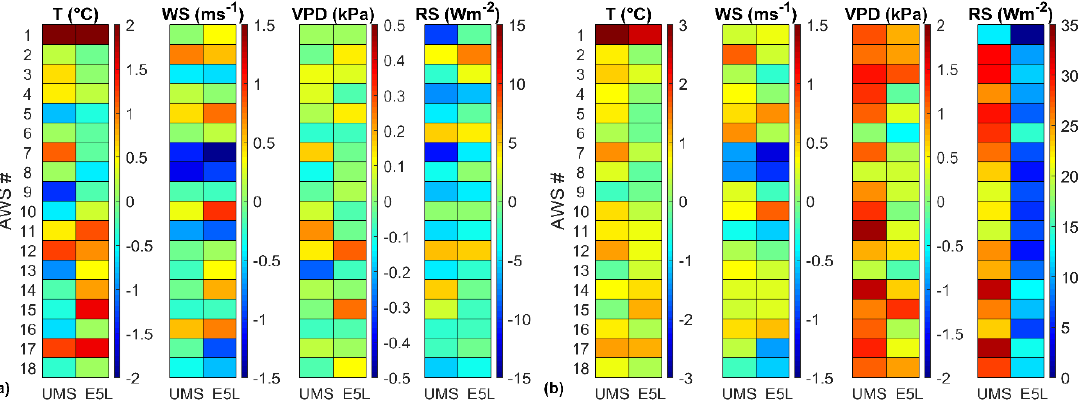
Figure 4. Differences between statistical indicators of reanalysis data (UMS and E5L) and kriging (Figure 3): ( a ) absolute BIAS; ( b ) RMSE.